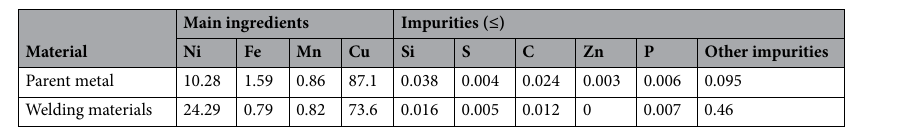
Table 1. The composition of B10 copper-nickel alloy welding joint.